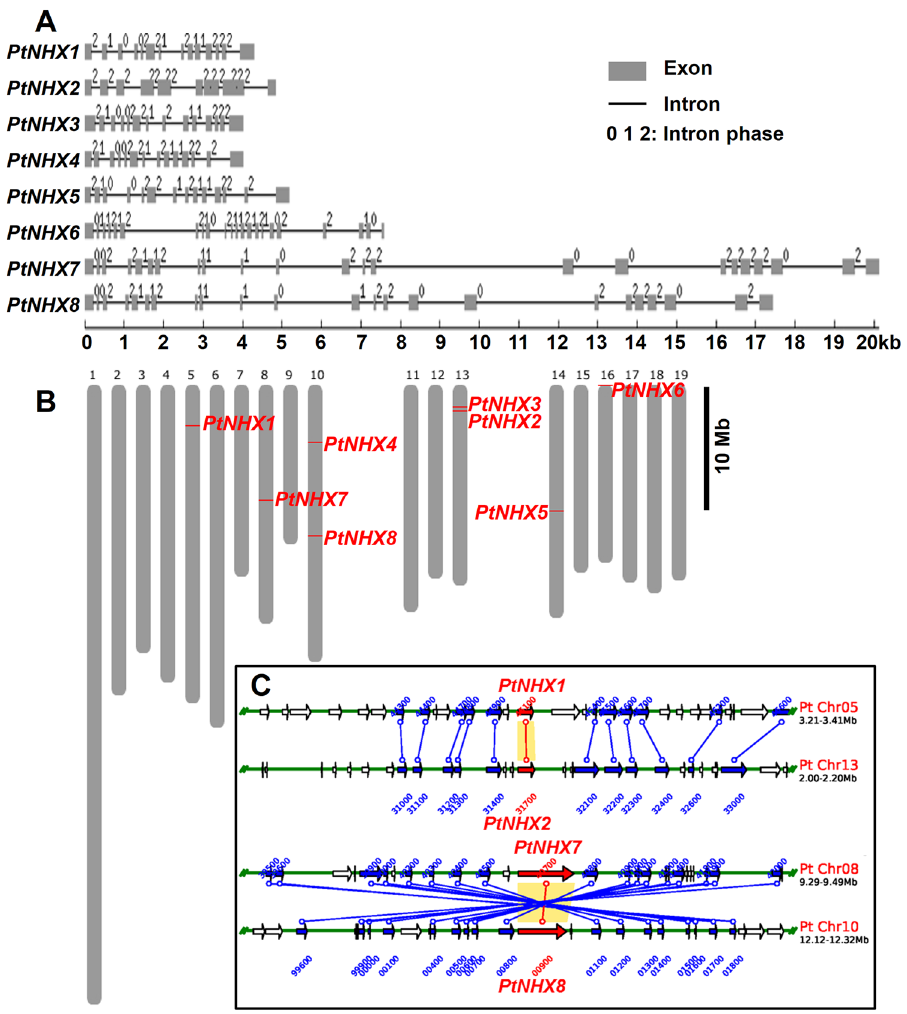
Figure 2. PtNHX gene structure, map position, and duplication analysis. ( A ) Gene structures of the PtNHXs . ( B ) Location of PtNHXs on P. trichocarpa chromosomes. ( C ) The duplicated PtNHXs (red labelled) from PGDD